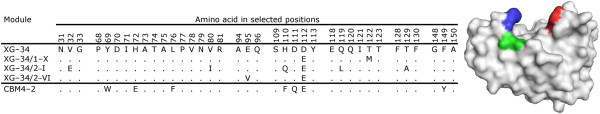
Protein sequences. Sequence alignment of XG-34, the three evolved modules XG-34/1-X, XG-34/2-I and XG-34/2-VI and CBM4-2. Residue numbering is in agreement with Simpson et al [22]. Dots indicate identity with XG-34 sequence. The close proximity of residue 112 (green), mutated in evolved variants of XG-34, to residues 110 (blue) and 69 (red) that are important for carbohydrate binding in proteins based on the scaffold [15,22], is highlighted on a structure model of XG-34/1-X.